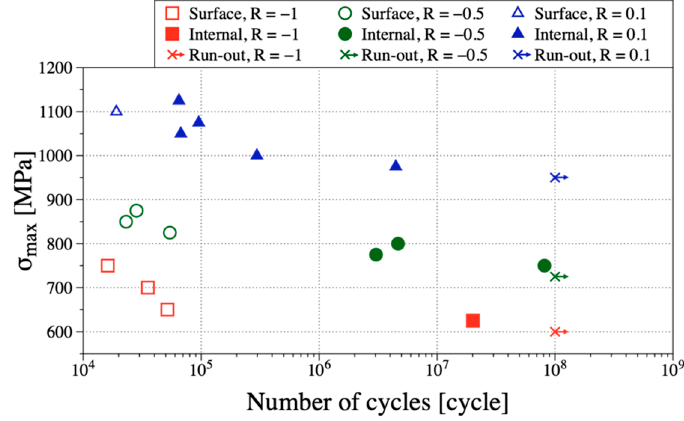
Figure 2. Relationship between the maximum applied stress and the number of cycles to fracture for